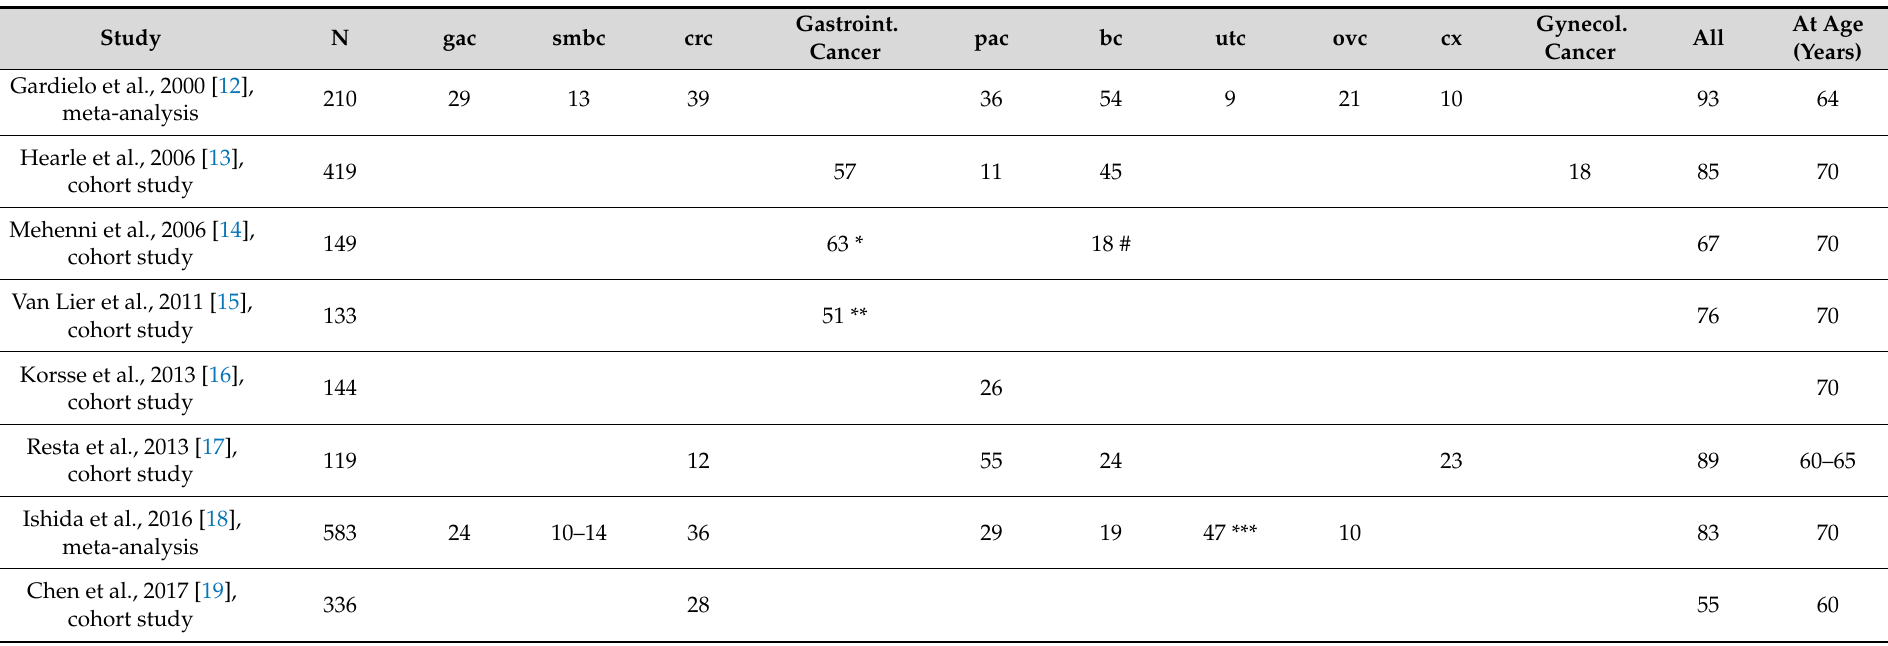
Table 2. Studies on cumulative cancer risks in Peutz–Jeghers